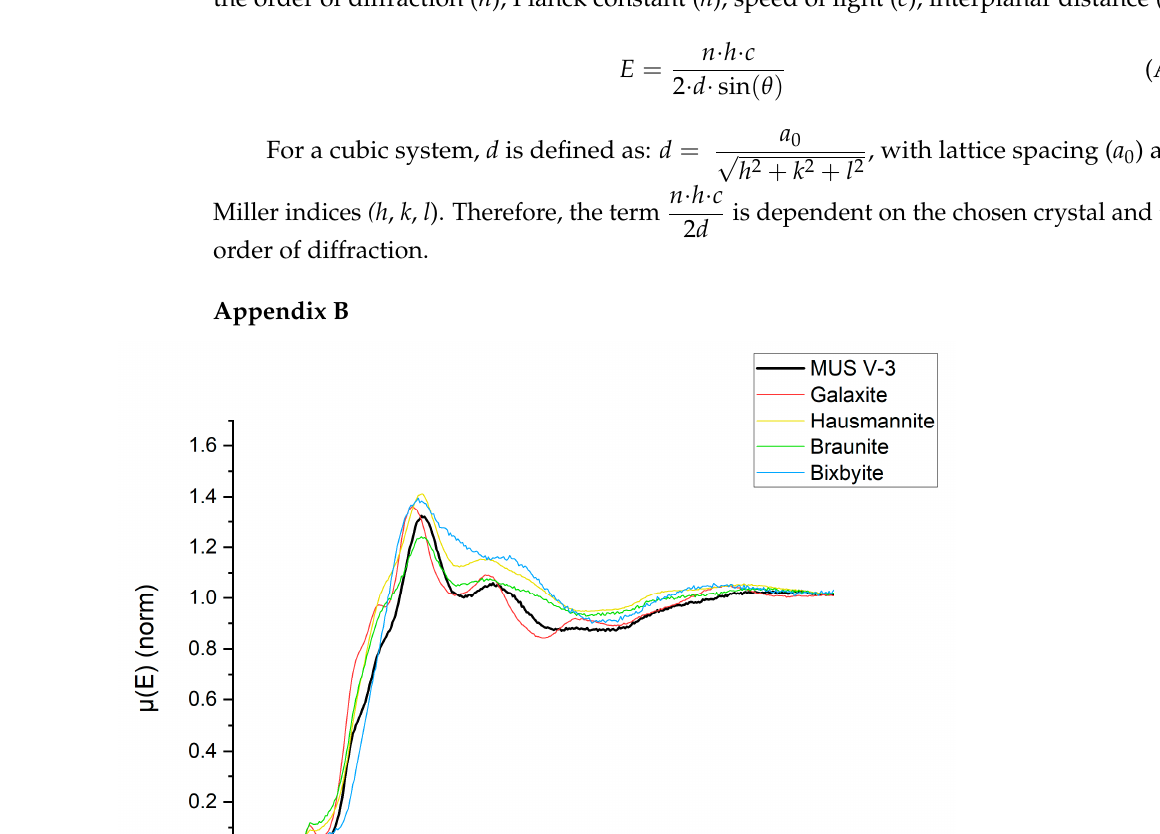
Figure A3. Linear combination of hausmannite (H) and bixbyite (B).